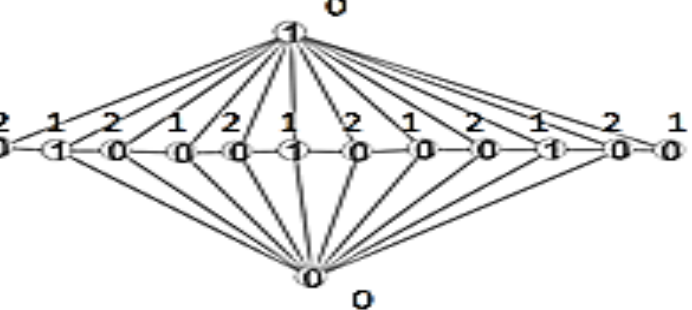
Figure 9 . Switching with modular coloring in